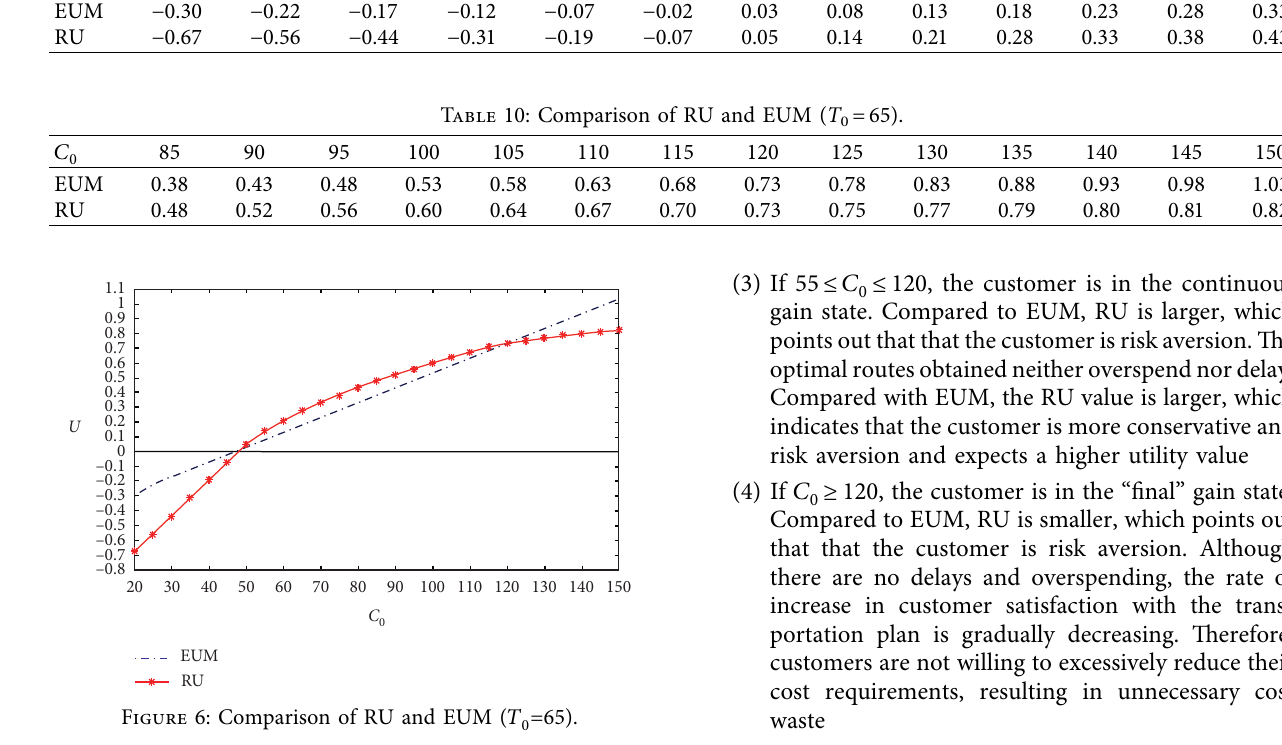
Table 9: Comparison of RU and EUM ( T